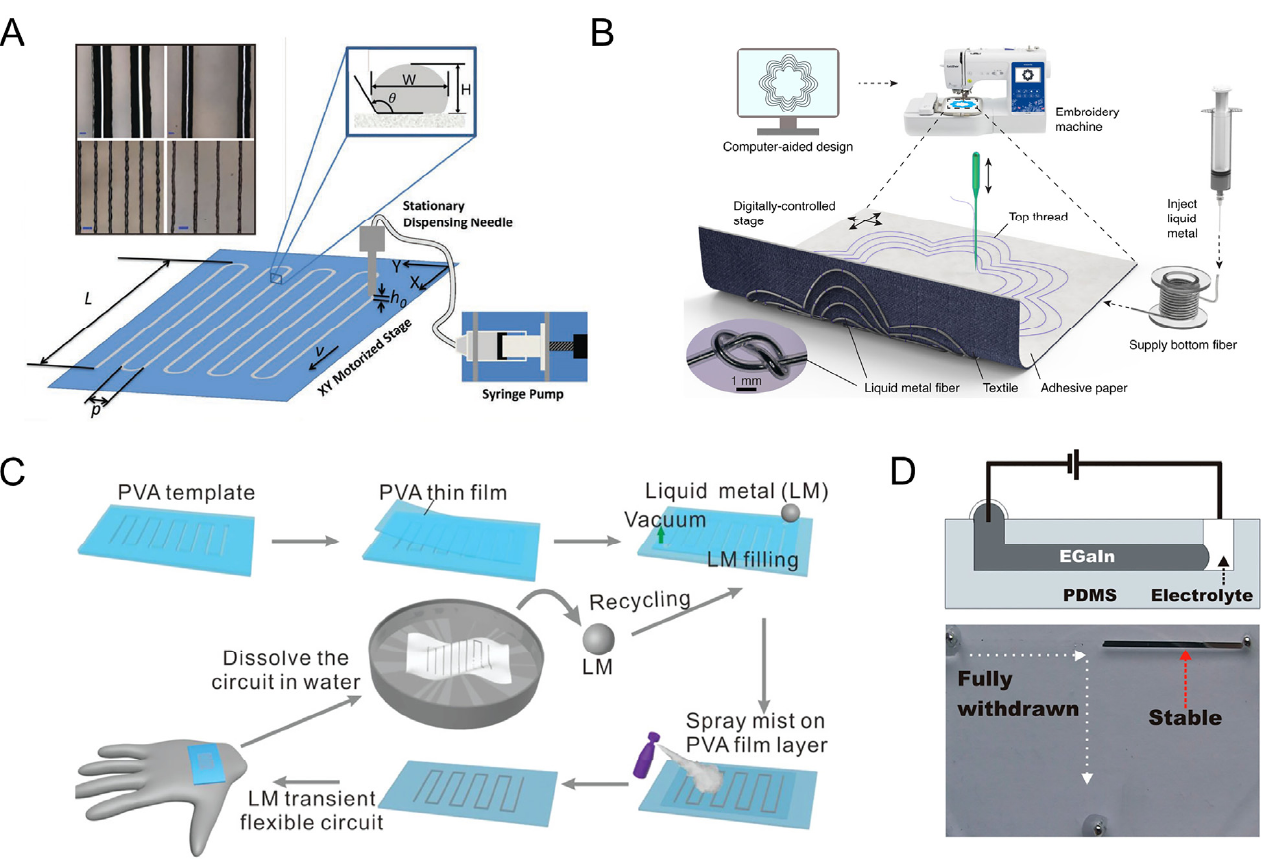
Figure 5. The fabrication strategies of conductive circuits with pure LM. ( A ) The direct writing sys- tem and the high-resolution wires directly written with LM [62]. Copyright: (2014) WILEY-VCH. ( B ) Illustration of the digital embroidery process using liquid metal fibers [63]. Copyright: (2022) Springer Nature. ( C ) Schematic illustration of the fabrication and recycling process of the room tem- perature LM-based PVA-encapsulated, recyclable, transient circuits [64]. Copyright: (2019) WILEY- VCH. (D) Schematic and photograph of the recapillarity-induced withdrawal of LM from micro- channels [66]. Copyright: (2014) National Academy of Sciences.